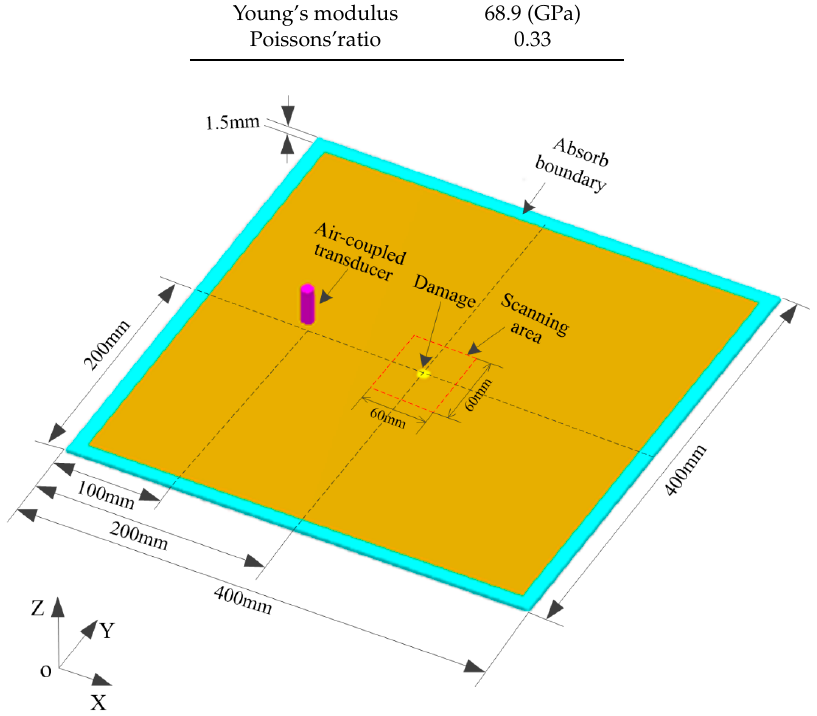
Figure 4. Finite element model.